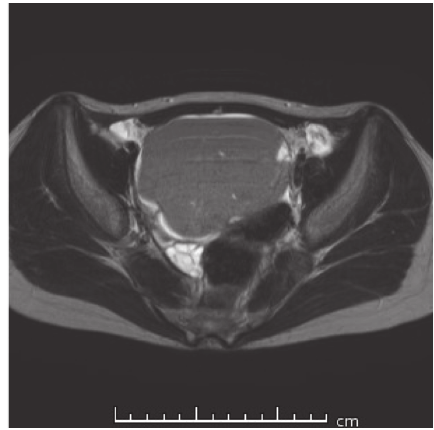
Figure 1: Pelvic magnetic resonance imaging (T2-weighted image) before the first surgery of Case 1. An intrapelvic tumor (9.2 × 7.6 × 7.5 cm in diameter) with high signal intensity is detected. The right ovary is normal.